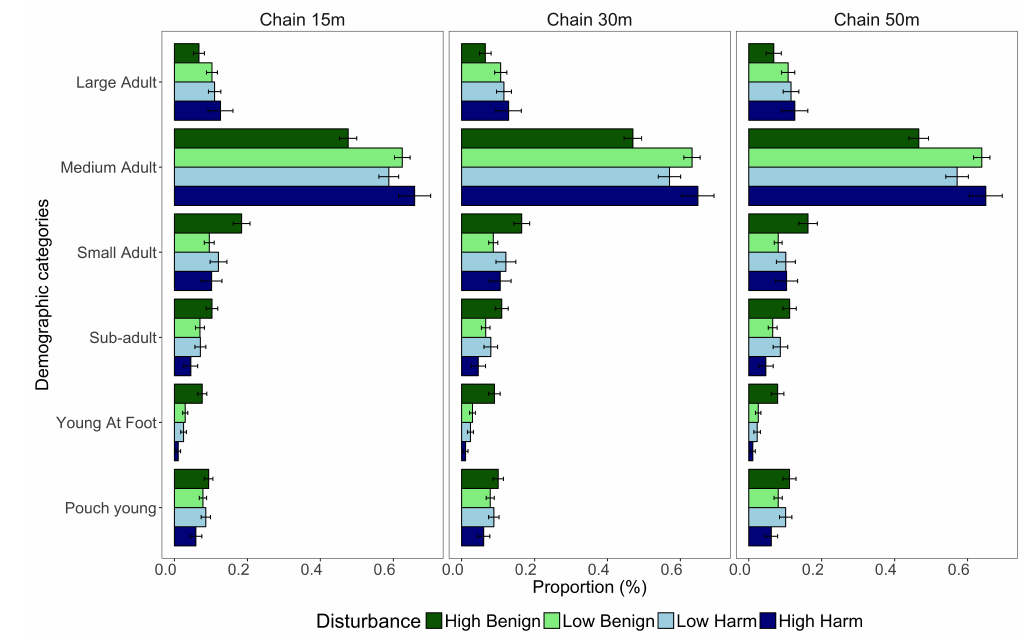
Figure 5. Demographic composition across different disturbance types using three measures of chain-rule to determine group membership; 15 m, 30 m, and 50 m. Demographic categories were large adult, medium adult, small adult, sub-adult, young-at-foot, and pouch young. Values are mean proportional contributions to groups, while error bars indicate standard